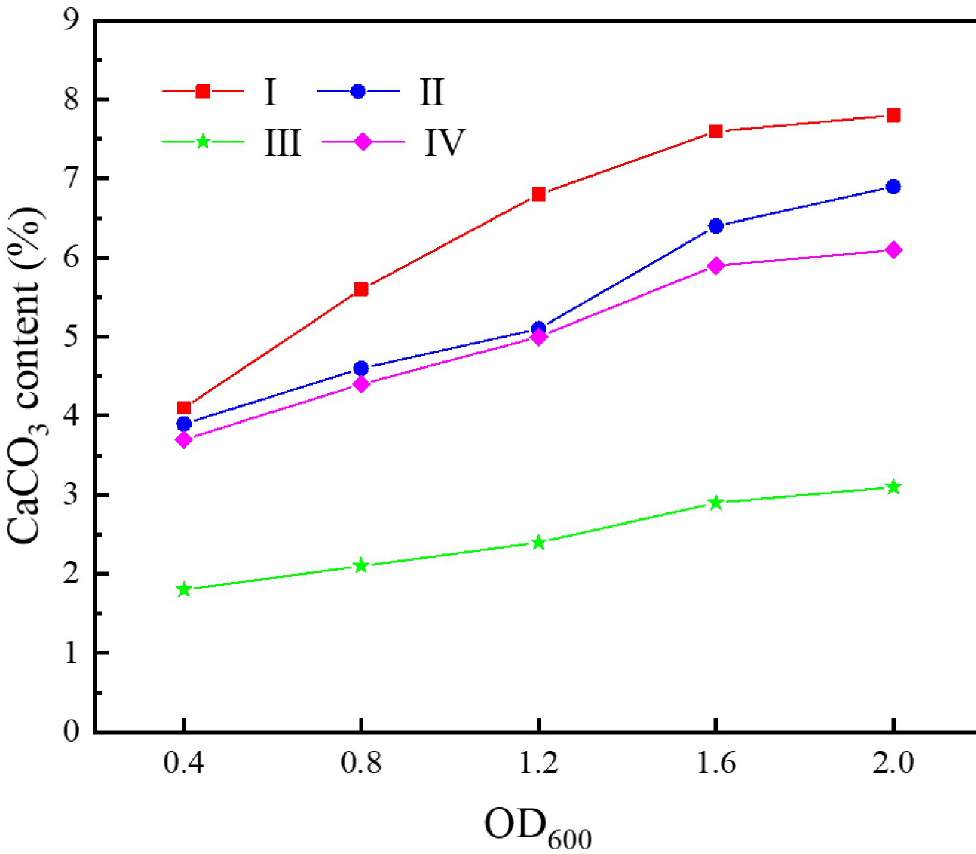
Fig 8. Relationship between bacterial solution concentration and CaCO3 content in each